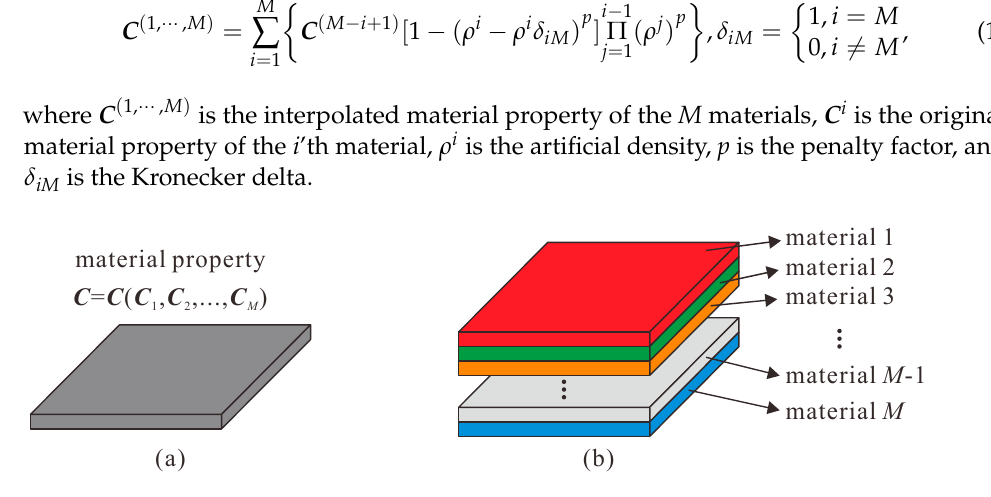
Figure 1. Multi-material models of multi-material topology optimization. ( a ) The conventional method using a single finite element; ( b ) the element stacking method selecting only one element from multiple elements.